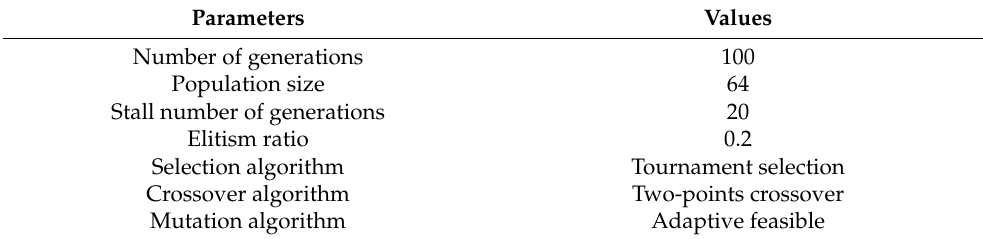
Table 1. GA parameters and algorithms for training.